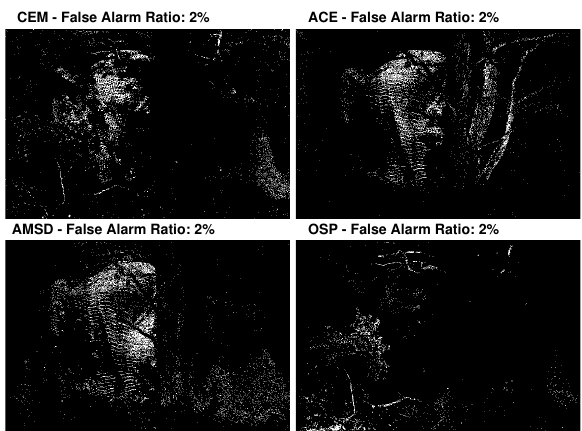
Figure 8. Detection results - concealed vehicle using printed